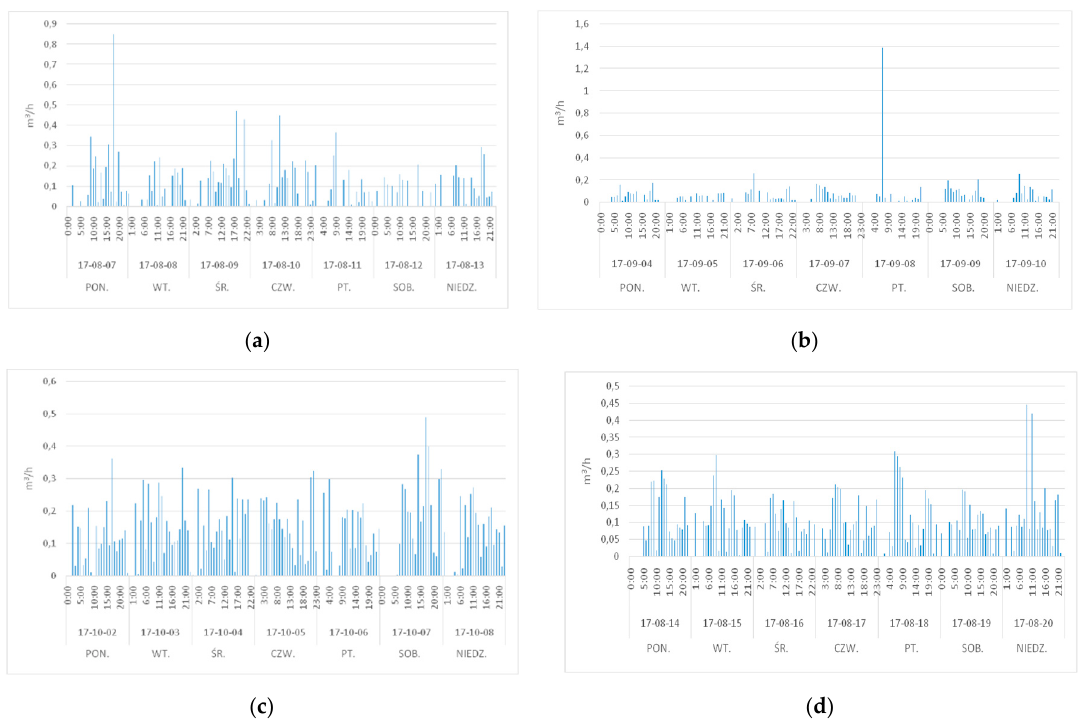
Figure 2. The maximum of momentary volumetric flows in selected single-family houses: ( a ) Building No. 1, ( b ) building No. 6, ( c ) building No. 7 and ( d ) building No. 9.